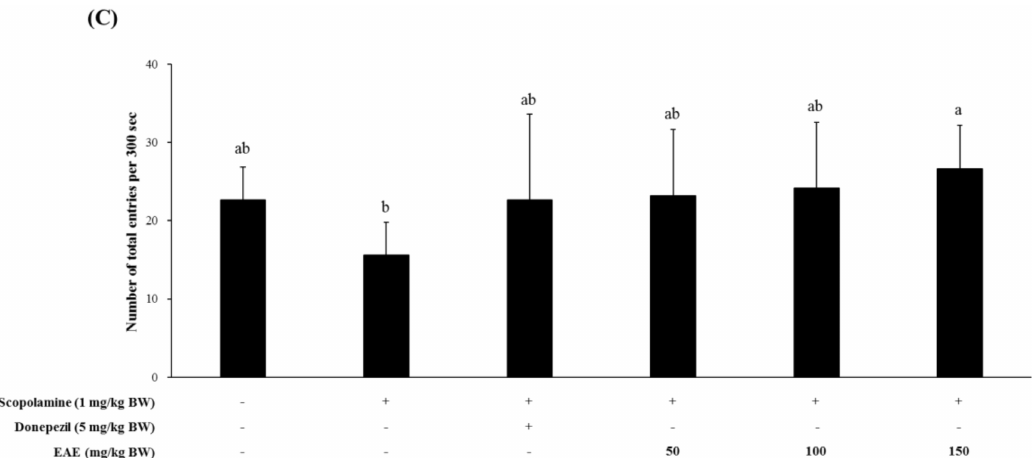
Figure 3. E ff ect of EAE on the scopolamine-induced memory deficit tested by the passive avoidance task ( A ), Morris water maze test ( B ), and Y-maze test ( C ). Results are expressed as mean ± SD ( n = 5). Statistical analysis was performed using one-way ANOVA, following Duncan’s multiple range test. Bars not sharing common alphabetical letters (a–c) represent significant di ff erences from each other ( p < 0.05).